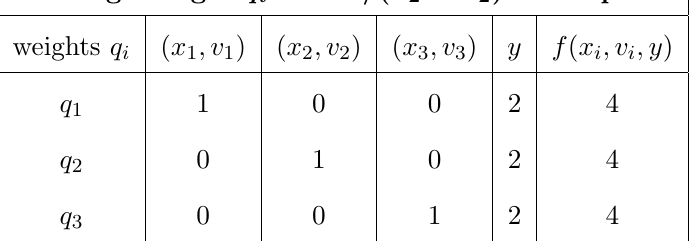
Table 7 . Overview of the weights q i for the coordinates ( x i ; v i ; y ) i =1 ; 2 ; 3 parametrising the toric space, as well as for the polynomial f allowing for the embedding of T 6 = ( Z 2 (cid:2) Z 2 ) as a hypersurface in this toric